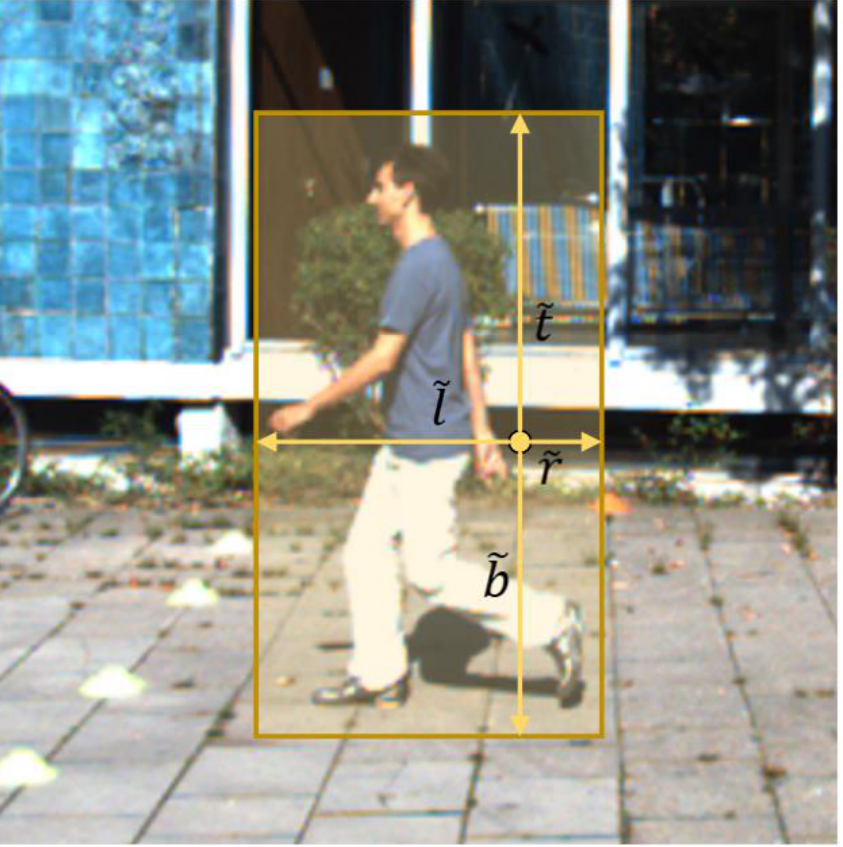
Figure 7. Labeling method for the bounding box. Each location has four parameters for the defini- tion.